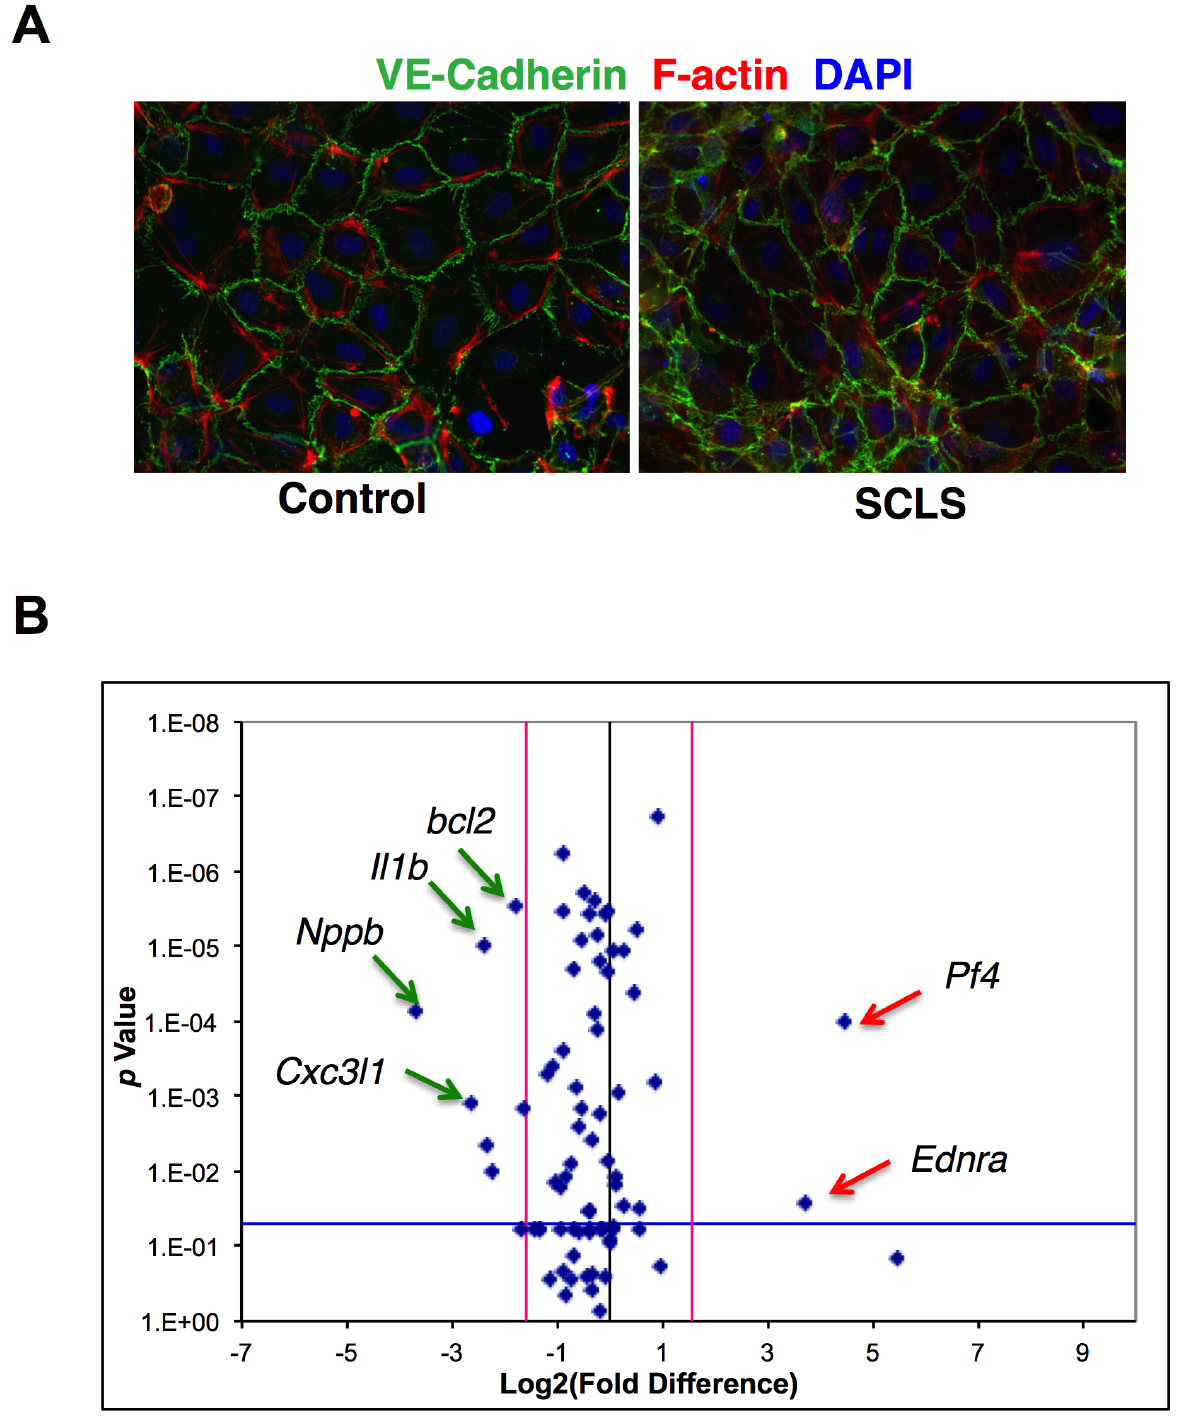
Fig 2. Morphology and gene expression in BOEC from SCLS patients and controls. (A) BOEC were expanded from peripheral blood. Image shows a representative EC monolayer immunostained with anti-VE-cadherin (green), F-actin (red), and DAPI (blue, nuclei). (B) Volcano plot of real-time qPCR array showing relative gene expression in SCLS BOEC relative to control on x axis and log p value on y